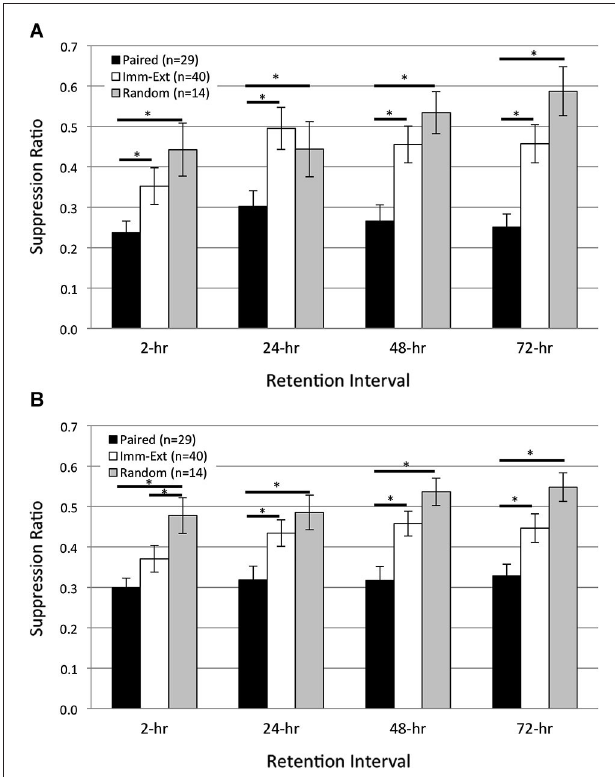
FIGURE 2 | Immediate extinction training attenuates pairing-produced phototactic suppression and returns phototactic behavior back to control (pre-pairing) levels, without evidence of spontaneous recovery . Summary data for start (A) and finish (B) latency suppression ratio (SR) scores measured at four different retention intervals (RIs) post-acquisition. Start and finish latency values were converted to SR scores for each animal (see Section Methods). Animals given paired training showed significant phototactic suppression (i.e., smaller SR scores) compared to animals given random training (non-associative control group) at all four RIs for both start (A) and finish (B) latency behavior. Immediate extinction training ( Imm-Ext group) given 15 min after paired conditioning greatly weakened the pairing-produced phototactic suppression and resulted in phototactic behavior that was similar to baseline control values. Imm-Ext animals showed significantly less phototactic suppression (greater SR scores) than Paired animals at the 2-h RI for start (A) , but not finish (B) latency behavior, and significantly less phototactic suppression at the 24-, 48-, and 72-h RI